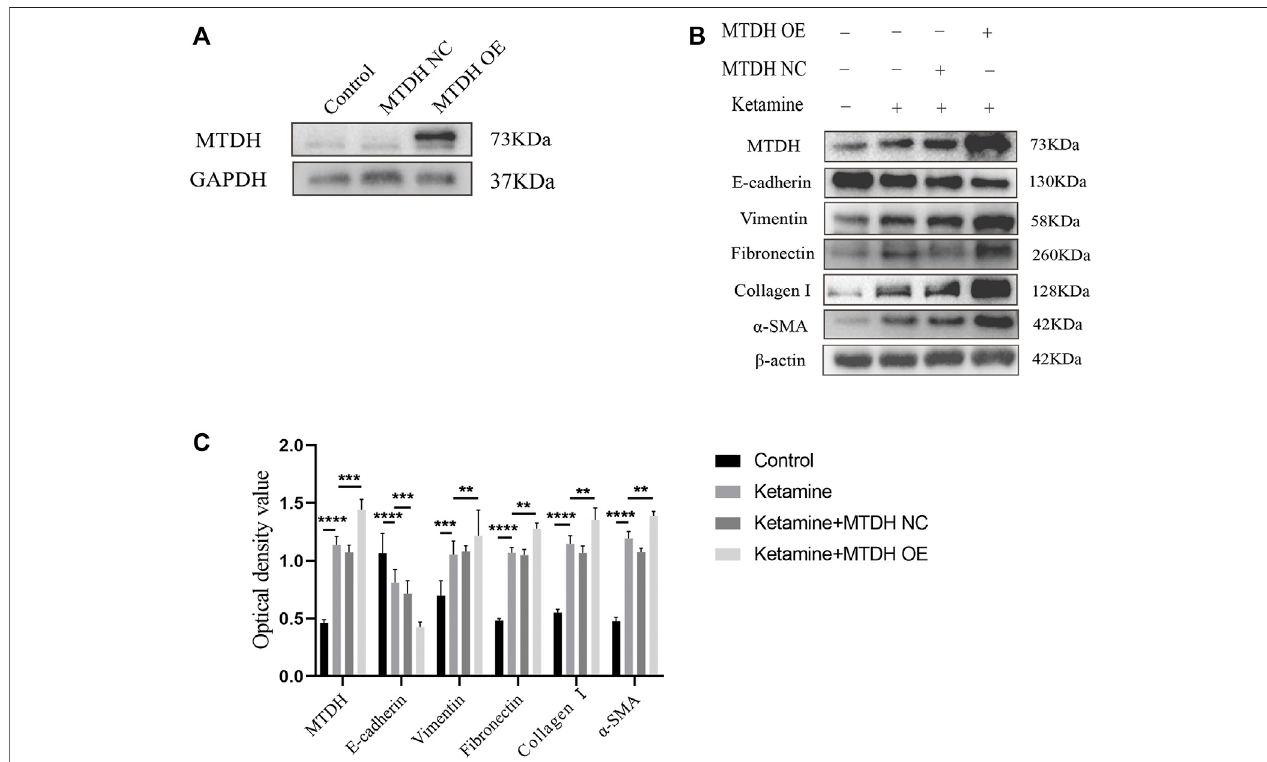
FIGURE5| MTDH,EMT,and fi brosismarkersproteinexpressionafterMTDHoverexpression. (A) RepresentativebandsfromWesternblotanalysesofthelevelsof the MTDH in SV-HUC-1 cells after being transfected with MTDH overexpression NC plasmid and MTDH overexpression plasmid. (B) Representative bands from Western blot analyses of the levels of the MTDH, E-cadherin, vimentin, fi bronectin, collagen Ⅰ , α -SMA protein in SV-HUC-1 cells after being treated with ketamine, ketamine and MTDH overexpression NC plasmid, ketamine and MTDH overexpression plasmid (treated for 48 h). (C) Relative levels of the MTDH, E-cadherin, vimentin, fi bronectin, collagen Ⅰ , α -SMA protein compared to β -actin. ** p < 0.01; *** p < 0.0001; **** p < 0.0001. N (cid:1) 3.